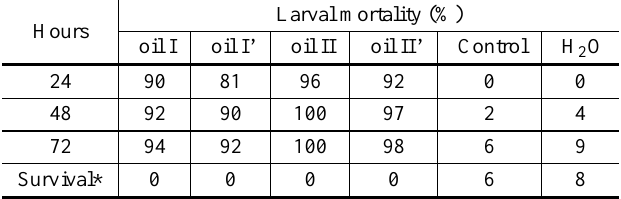
Nematicidal activity (%) of the essential oils from aerial parts of P. apodocephala (oil I and I’) and P. oligocephala (oil II and II’) expressed as the average of four repetitions for each treatment.